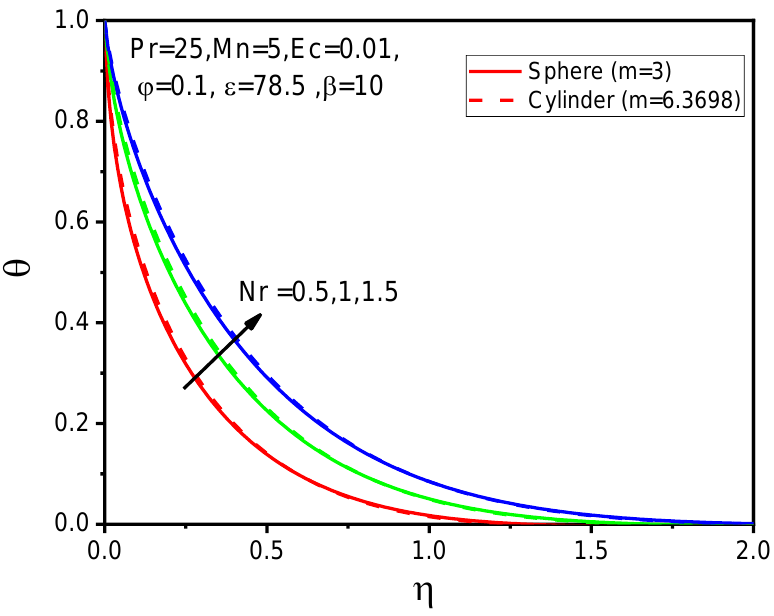
 Figure 14. (Case b): Variations of θ for Nr = 0.5,1,1.5 against η . Figure 14. (Case b): Variations of  for 0 5 1 1 5 Nr . , , . = against . Figures 15 and 16 represent the dimensionless velocity and temperature profiles, respectively, for various values of the Eckert number. As the Eckert number increases, both velocity and the temperature profiles are enhanced and especially the flow and heat of blood-Fe 3 O 4 are remarkably increased compared to pure blood. Major temperature of fluid is attained for Ec = 0.001, which indicates that lower values of the Eckert number are responsible for enhancing temperature in fluid regime due to the combined effects of the  for 0 5 1 1 5 Nr . , , . = against  . magnetic field parameter and ferromagnetic number. Figure 14. (Case b): Variations of